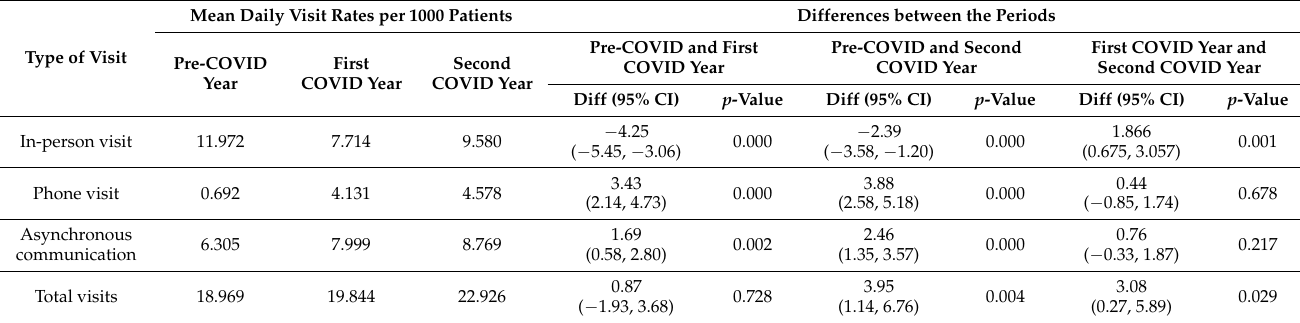
Table 2. Primary care visits by type and